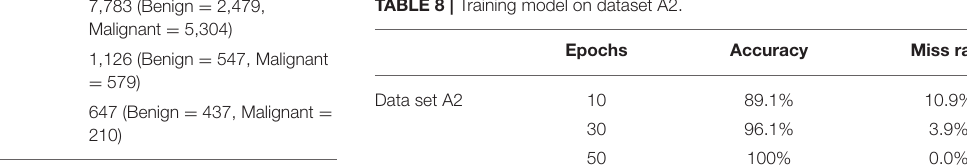
TABLE 8 | Training model on dataset